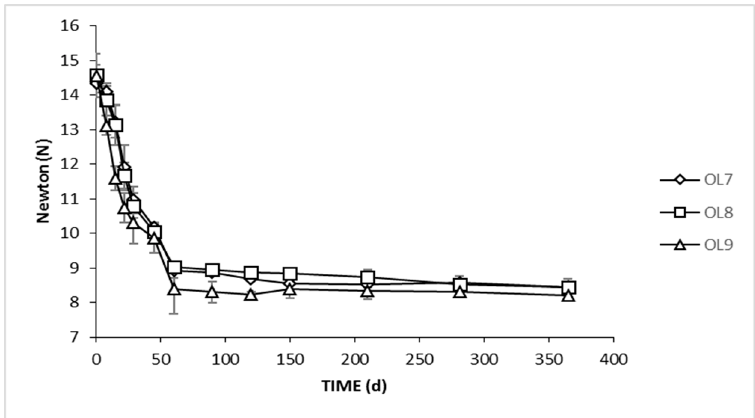
Figure 7. Evolution of texture of olive fruits during spontaneous ( ◊ ), inoculated (10% NaCl) ( □ ), and inoculated (7% NaCl) ( ∆ ) fermentation of Cypriot green cracked table olives. Data points are expressed as means (N) and standard deviations of 10 random measurements.